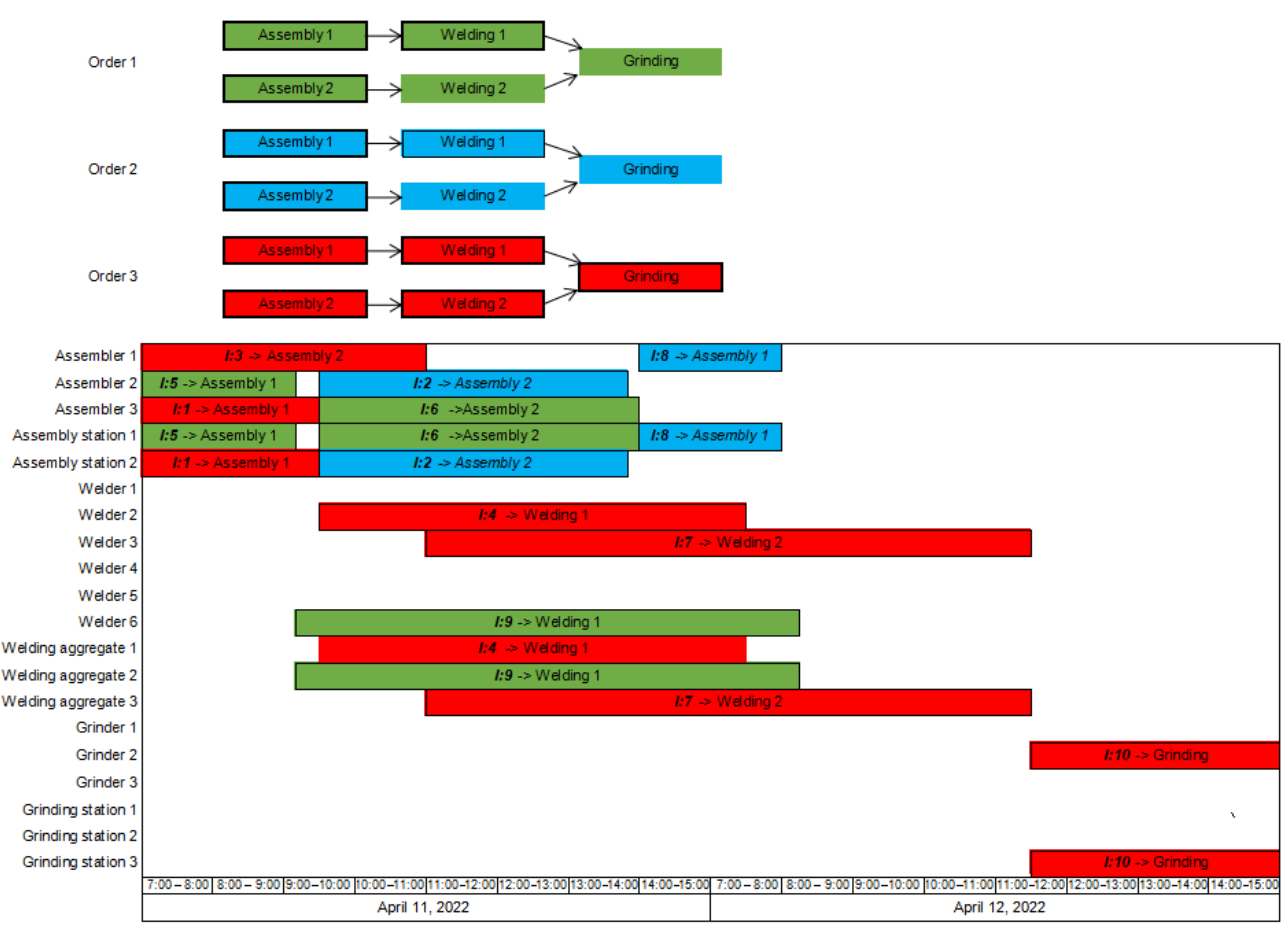
Figure 7. Example production schedule generation process for the scraper conveyor